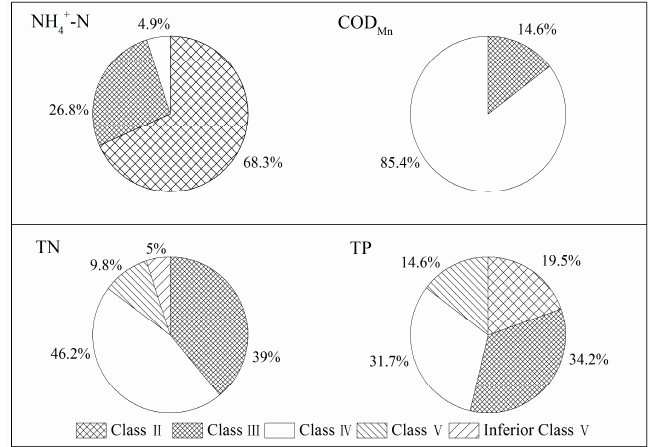
Figure 2. Degree of pollution for different water quality parameters in Honghu Lake.